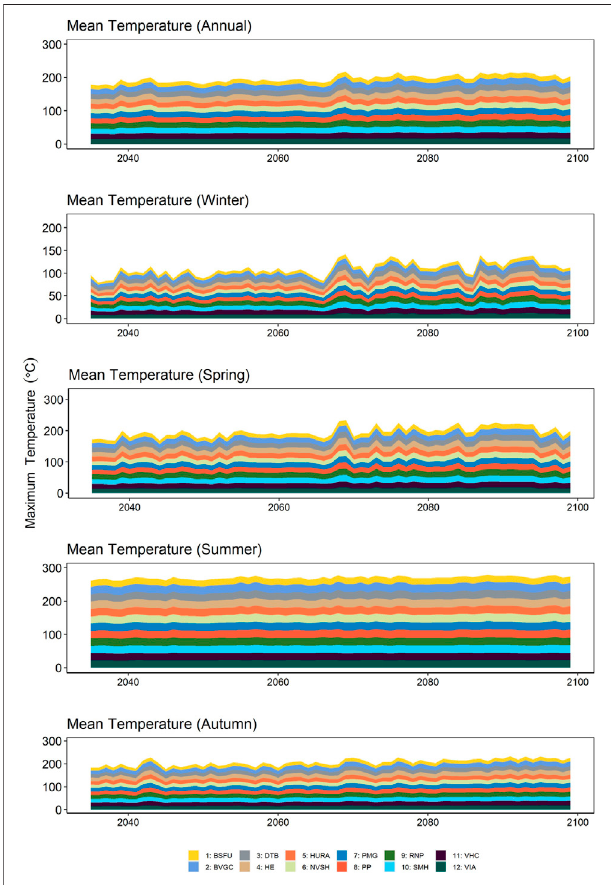
FIGURE7| Annualandseasonaltimeseriesofprojecteddailymaximum temperature between 2035 and 2100.